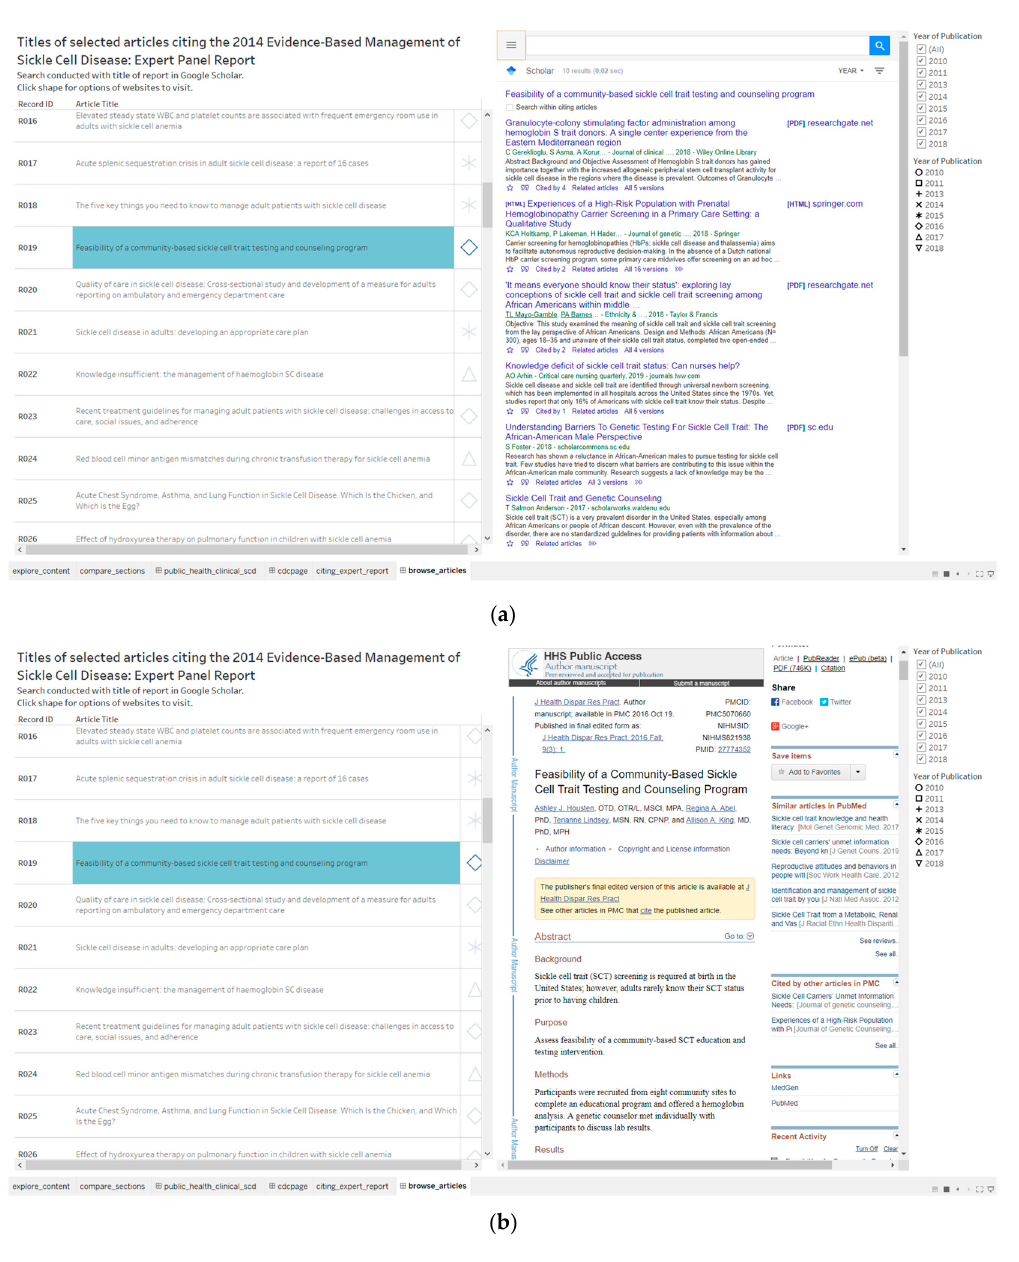
Figure 6. A dashboard combines an enclosure table and a website to browse articles on public health and clinical aspects of sickle cell disease. ( a ) Result of a Google Scholar search in the dashboard; ( b ) display of journal article web page.